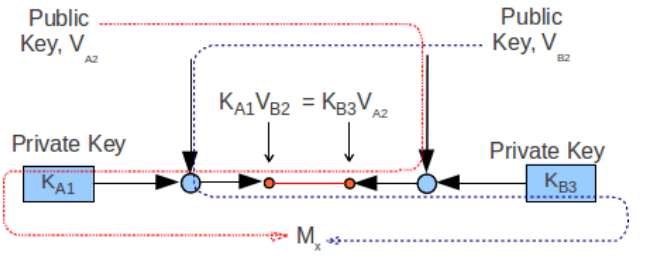
Figure 2. Pairing attack showing one of the matching